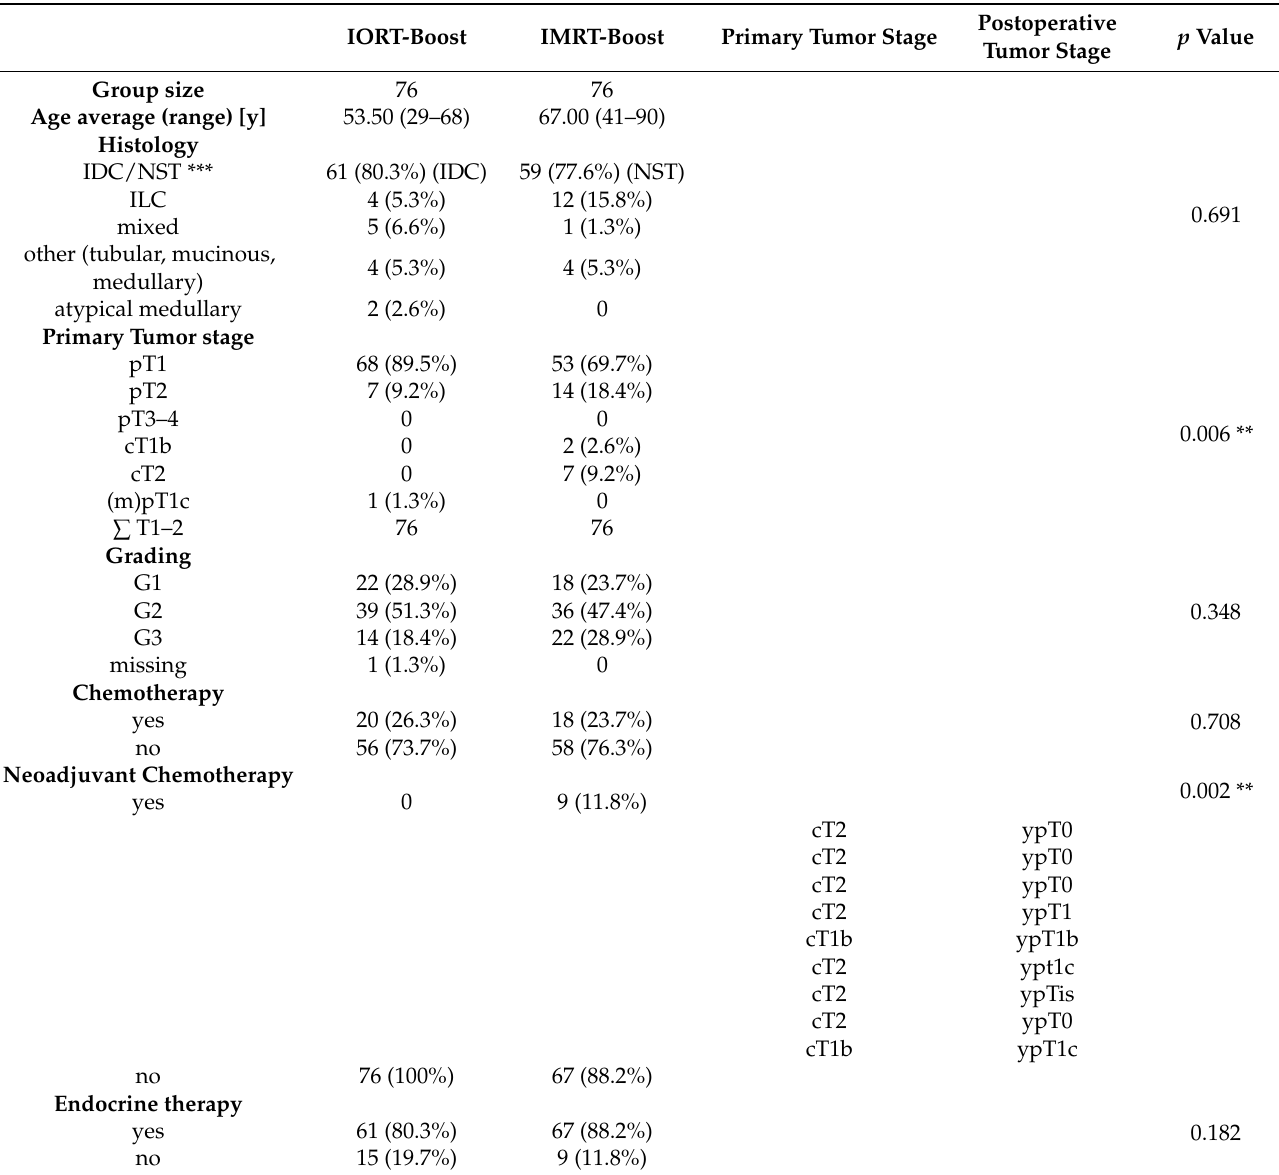
Table 1. Comparison of subgroups on different study parameters. p values were evaluated with chi-square